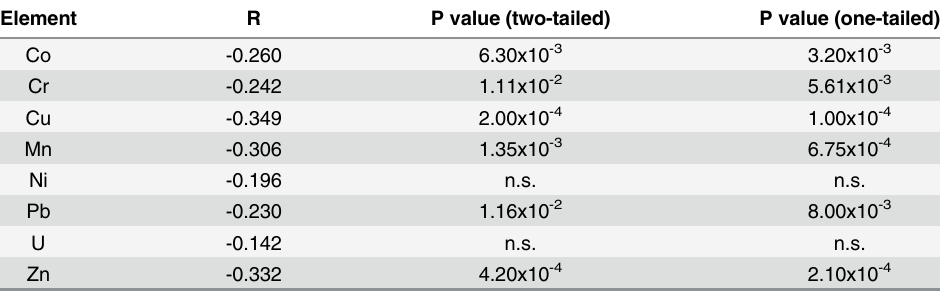
Table 3. Correlation coefficients between geochemical elements and T1D incidence rates, Element R